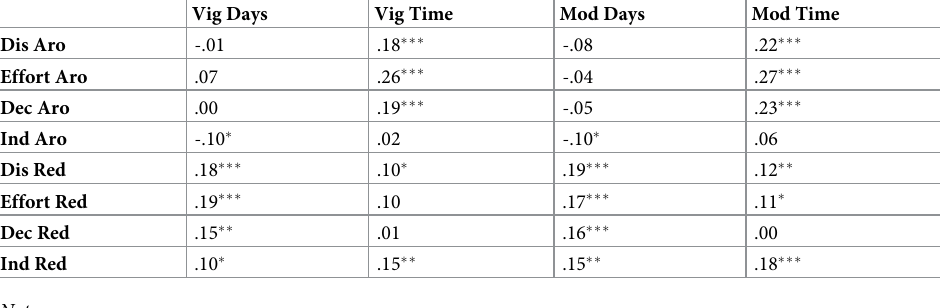
Table 7. Partial correlations of exercise variables with dissonance variables controlling for gender and age (Study 2). Vig Days Vig Time